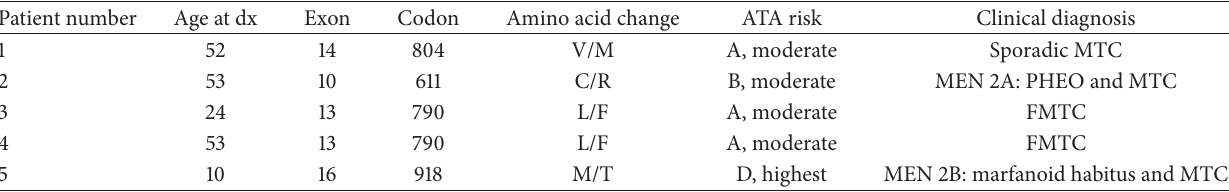
Table 1: Characteristics of patients with a positive germ-line RET mutation and